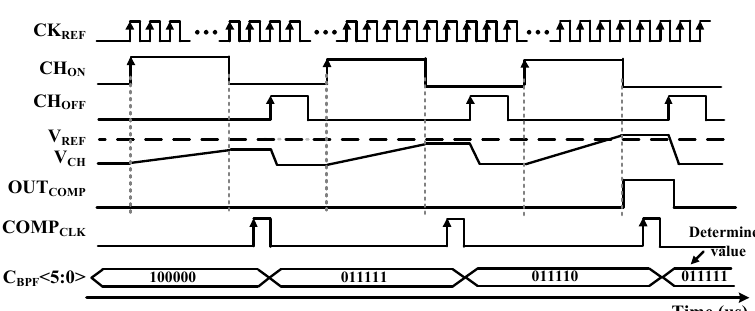
Figure 11. Timing diagram of the RC filter tuning circuit.